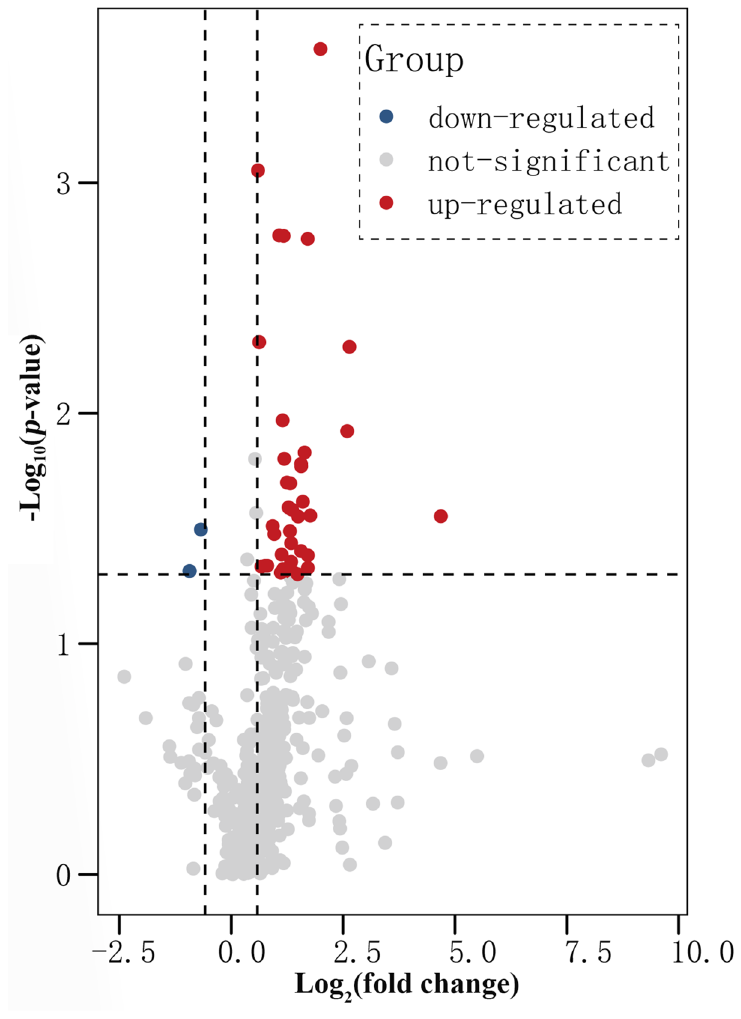
Figure 1. Volcano plot illustrating 486 miRNAs differentially expressed between Parkinson’s disease cases (n = 78) and healthy controls (n = 78) from cohort 1. A paired t-test was used to identify significantly differentially expressed